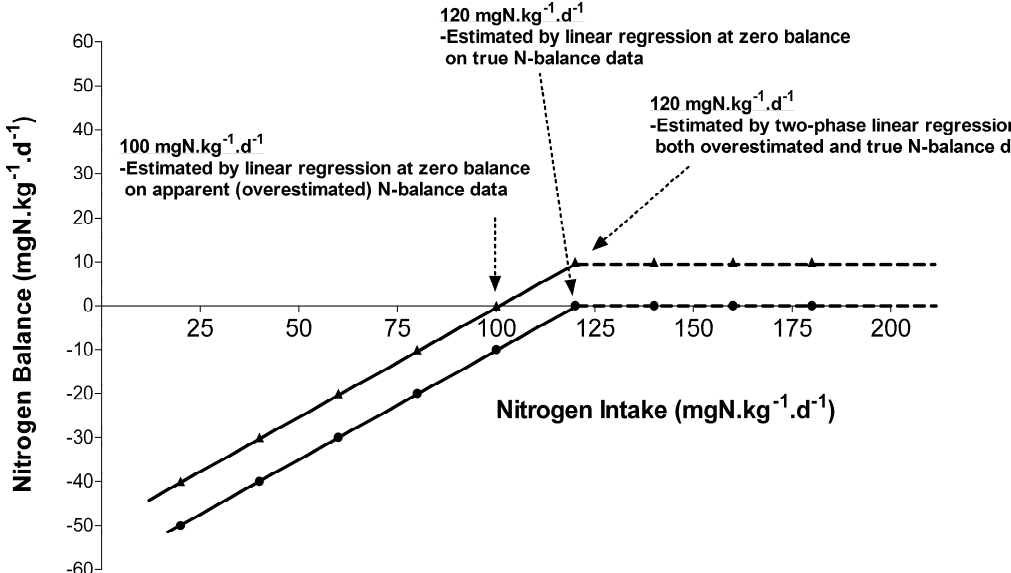
Figure 1. A hypothetical pattern of response in nitrogen balance observed due to increasing intakes of protein. A hypothetical example of the relationship between various protein intake levels and the nitrogen balances (true and apparent, 10% overestimated). Application of linear regression analysis on both true and overestimated nitrogen balance values resulted in nitrogen requirements of 100 and 120 mg/kg/day, respectively (0.63 and 0.75 g/kg/day, protein respectively). Application of the two-phase linear regression analysis on both true and overestimated nitrogen balance values resulted in a nitrogen requirement of 120 g/kg/day. Application of linear regression analysis underestimated nitrogen requirements by 20% when the nitrogen balance values were overestimated by 10%. Adapted with permission from [19].